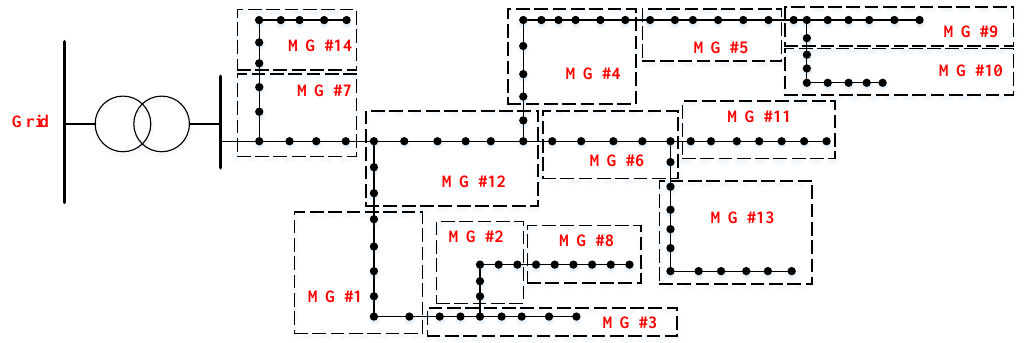
Figure 9. Network topology of 14 microgrids in Guizhou Province,